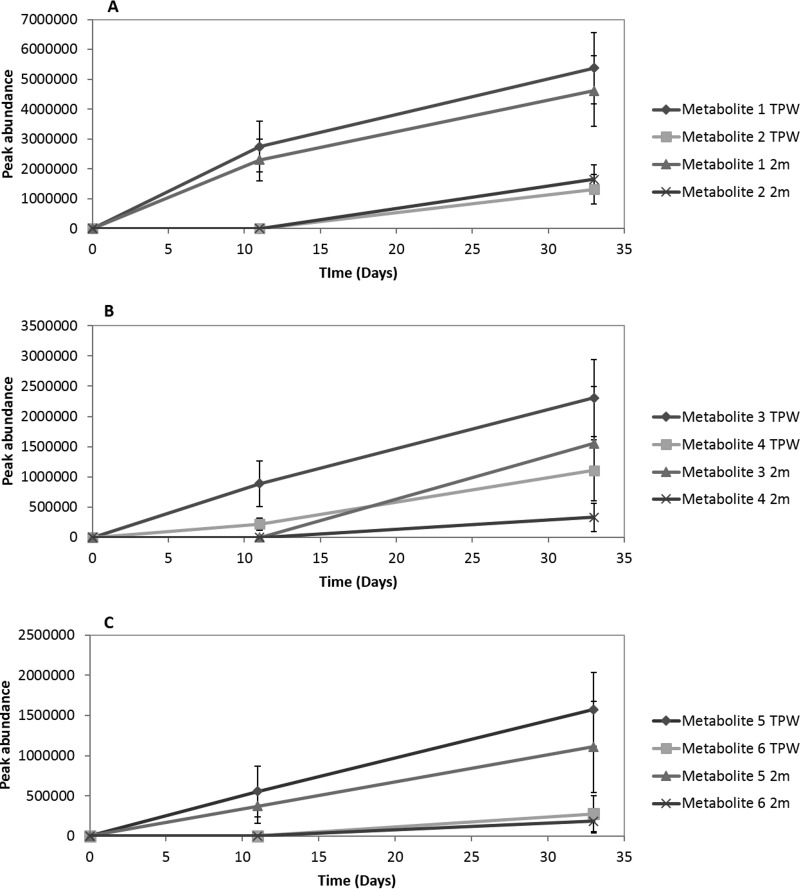
Production of metabolites tentatively identified during the transformation of Pyr (A), BaP (B), and BbF (C) by microbial communities derived from sample TPW. Error bars represent the standard error of the mean (n = 3).